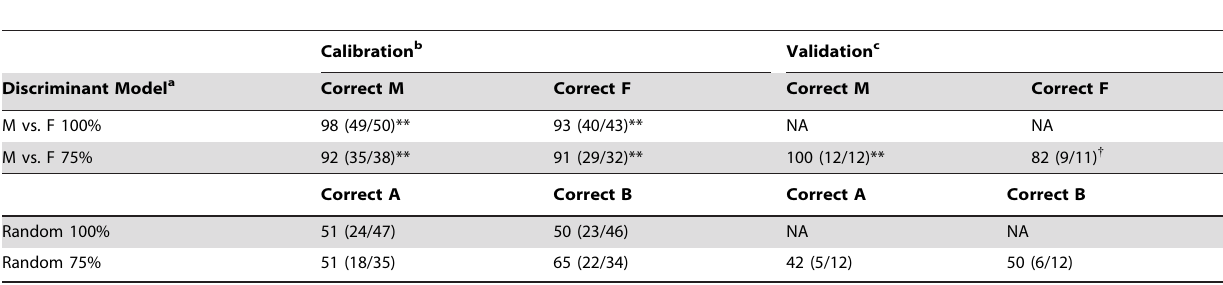
Table 4. Application of near infrared spectroscopy of feces to discriminate between juvenile male and female captive giant pandas ( Ailuropoda melanoleuca ) housed in US zoos.